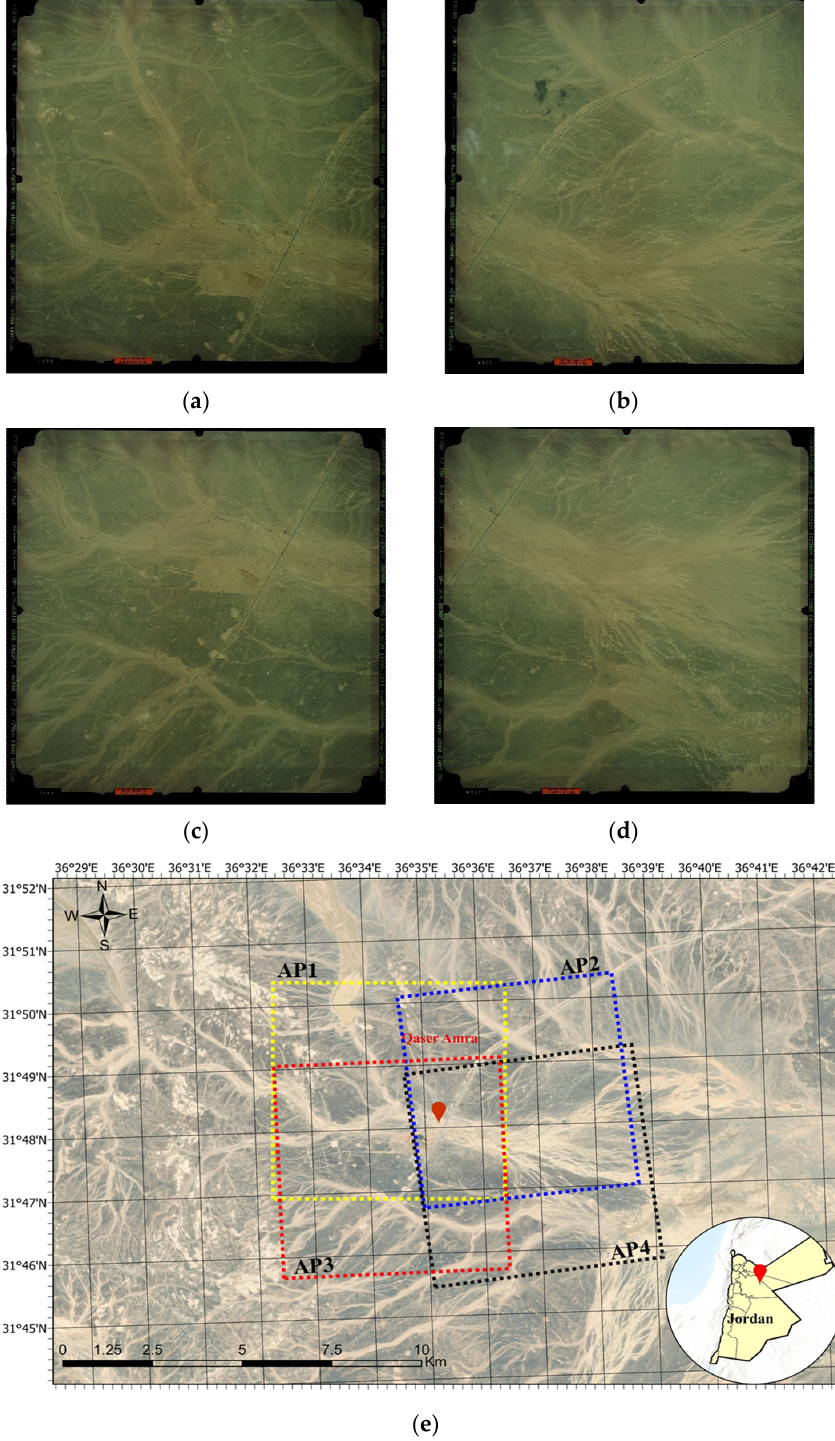
Figure 5. Aerial photos of Qaser Amra: ( a ) Aerial Photo 1 (AP1); ( b ) Aerial Photo 2 (AP2); ( c ) Aerial Photo 3 (AP3); ( d ) Aerial Photo 4 (AP4); ( e ) Layout of the overlapping aerial photos (yellow for AP1, blue for AP2, red for AP3, and black for AP4).